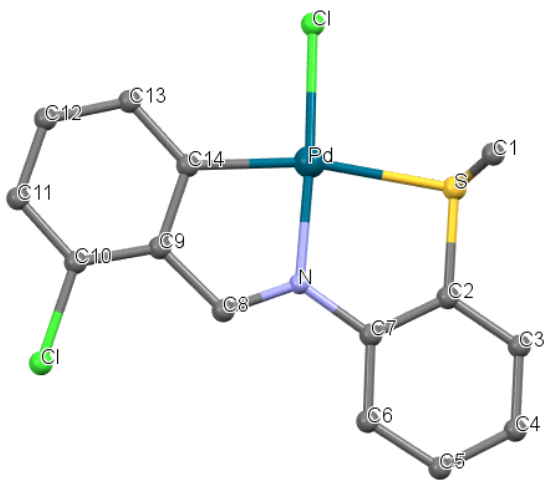
Figure 3. Molecular structure and atom–labeling scheme for ( 1c ).